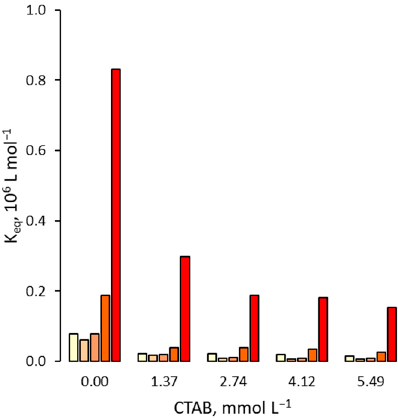
Figure 3. Binding affinity of 2,4,5-T for the MIP in presence of increasing amounts of CTAB. For each group of bars from left to right: water molar fraction from 0 (pure acetonitrile) to 0.24, 0.42, 0.66 and 0.81.